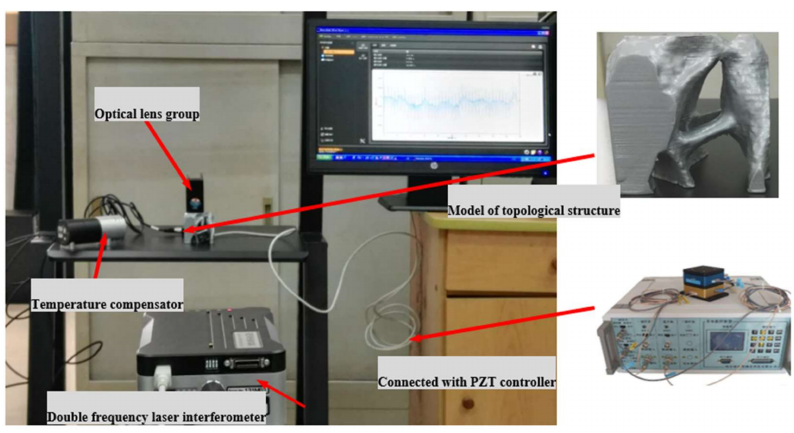
Figure 10. Experimental